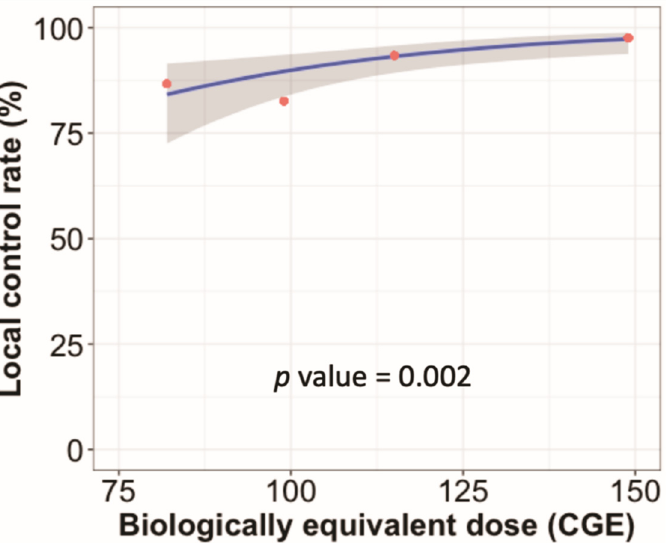
Figure 3. Radiation dose–response analysis. The blue line indicates the predicted local control rate determined by a generalized linear model according to the biologically equivalent dose using α / β = 10 Gy (BED 10 ). The red circles indicate estimated local control rates for groups by radiation dose categories. The radiation dose categories were BED 10 of 75–90 ( n = 45), 90–110 ( n = 23), 110–130 ( n = 61), and 130–150 CGE ( n = 160). The estimated local control rates for these categories were 86.7%, 82.6%, 93.4%, and 97.5%, respectively.